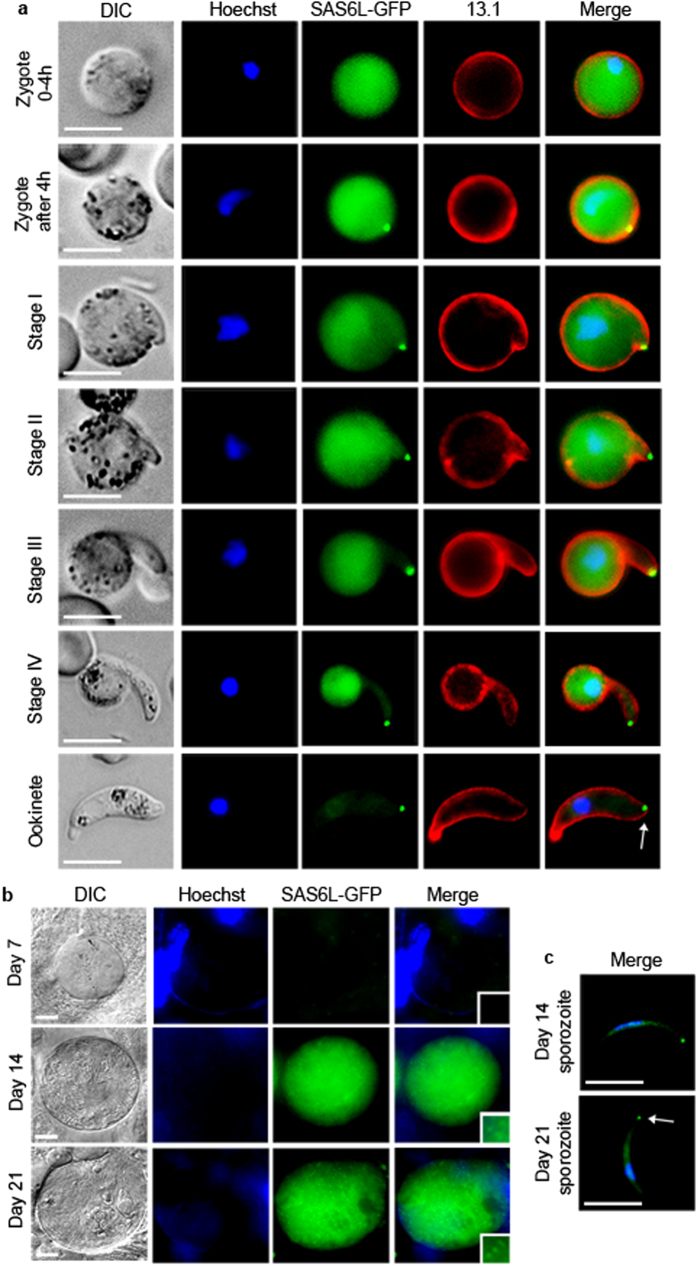
Developmental profile of SAS6L in ookinetes and sporozoites.(a) Localisation of SAS6L-GFP throughout the different stages of ookinete development (from early zygote to ookinete stages). 13.1 labels the surface (red) of the sexual stages as for Fig. 1. Nuclei were detected using Hoechst 33342 (blue), and the cells were displayed by differential interference contrast (DIC). Merge is the composite of Hoechst, GFP and 13.1. (b) Localisation of SAS6L-GFP throughout the mosquito development (from 7 dpi to 21 dpi). Merge is the composite of Hoechst and GFP. (c) Localisation of SAS6L-GFP in isolated 14 and 21 dpi sporozoites. Scale bars = 5 μm.